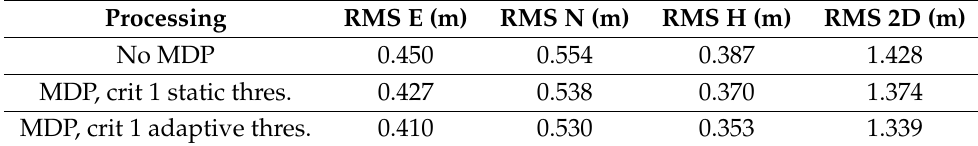
Table 3. Comparison between RMS obtained after MDP application, with criterion